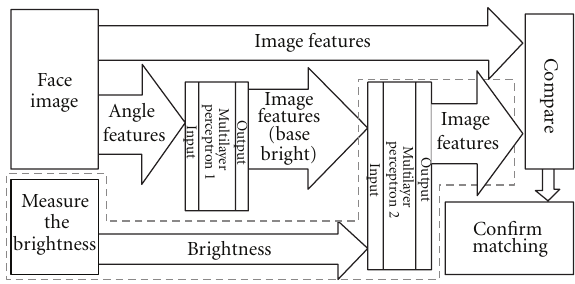
Figure 7: Block diagram of System